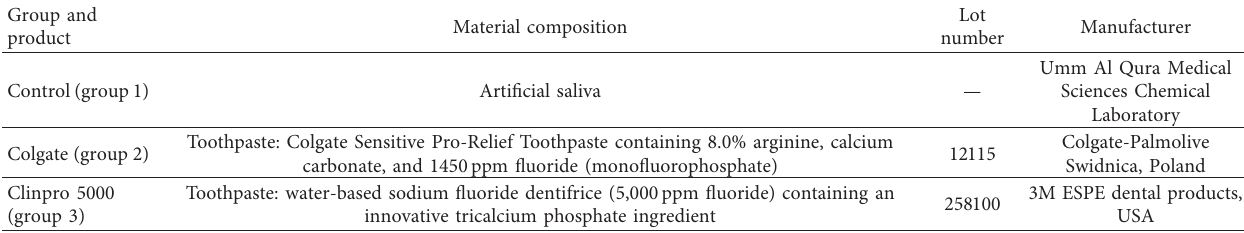
Table 1: The composition of different